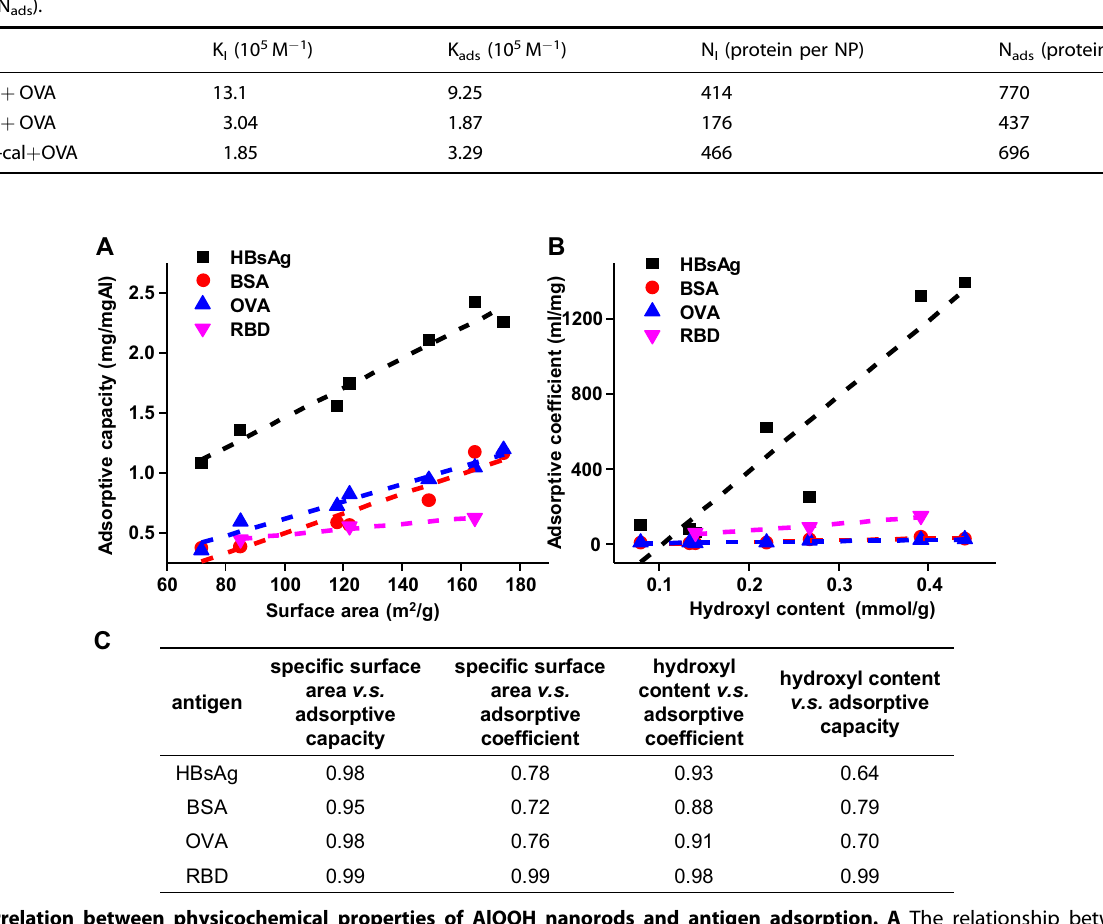
Fig. 5 Correlation between physicochemical properties of AlOOH nanorods and antigen adsorption. A The relationship between the speci fi c surface area of AlOOH nanorods and adsorptive capacity. B The relationship between the surface hydroxyl contents of AlOOH nanorods and adsorptive coef fi cient. C The Pearson correlation coef fi cient between the physicochemical properties of AlOOH nanorods and the antigen adsorption